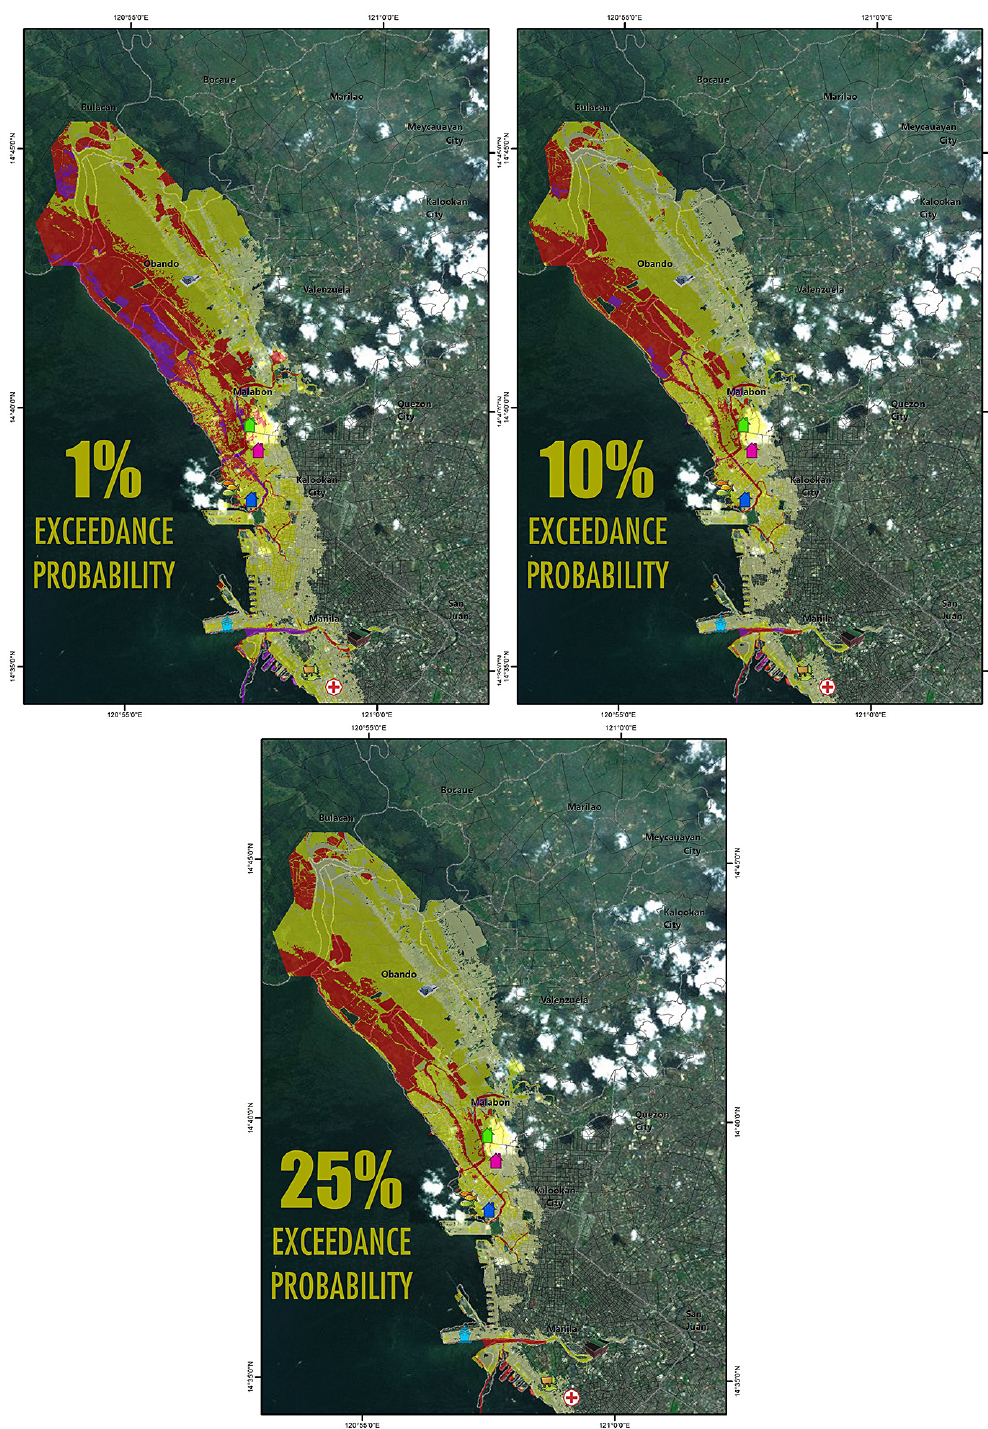
Figure 10. Storm surge inundation maps for PSWS 2 (please refer to Fig. 12 for the